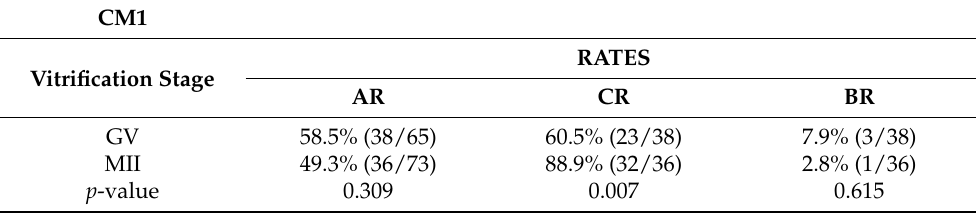
Table 3. Activation rate (AR), cleavage rate (CR), and blastocyst rate (BR) evaluated relative to the maturation stage prior to vitrification in the groups studied (GV and MII), both in CM1 medium. Average proportions by group and p -value.